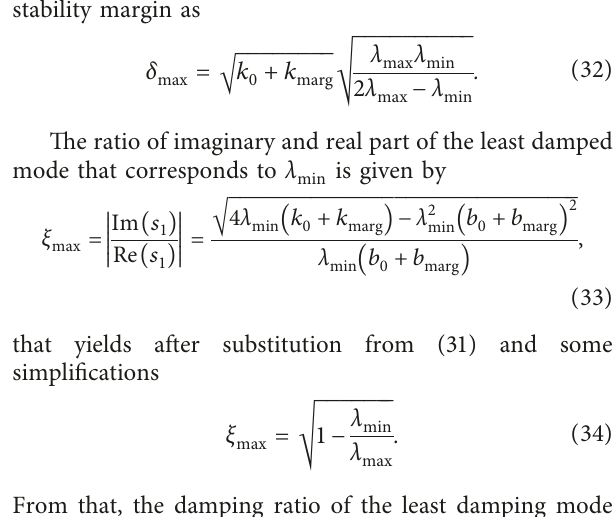
Figure 3: Comparison of stability margins of both approaches depending on number of nodes.